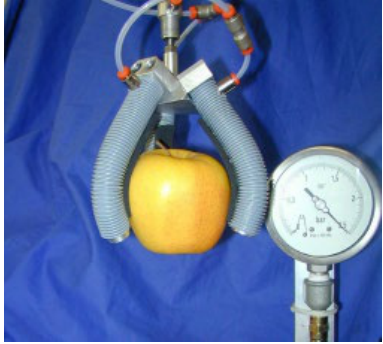
Figure 16. Fruit-picking hand [35].